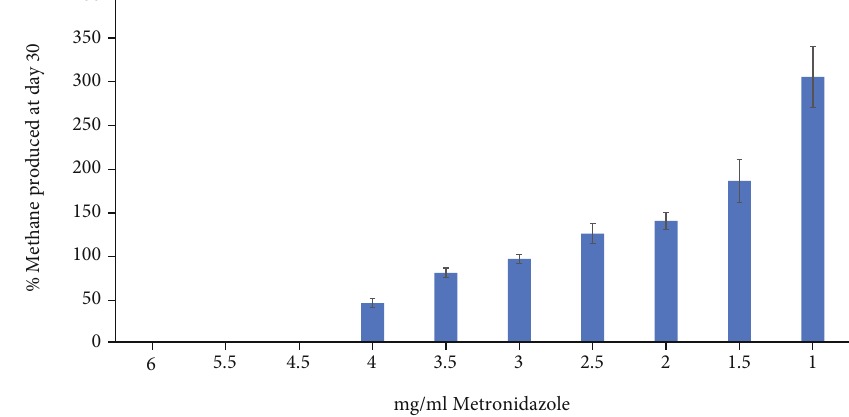
Figure 2: The e ff ect of metronidazole on the methane production of M. ruminantium following 30 days of incubation. Metronidazole at varying concentrations was added to cultures of M. ruminantium and incubated at 37 ° C for 30 days. On day 30, the methane concentration was measured and compared to an untreated control, which at day 30 gave an average concentration of 22.7% methane (Figure 1). Results are an average of 3 separate repeats ± SE